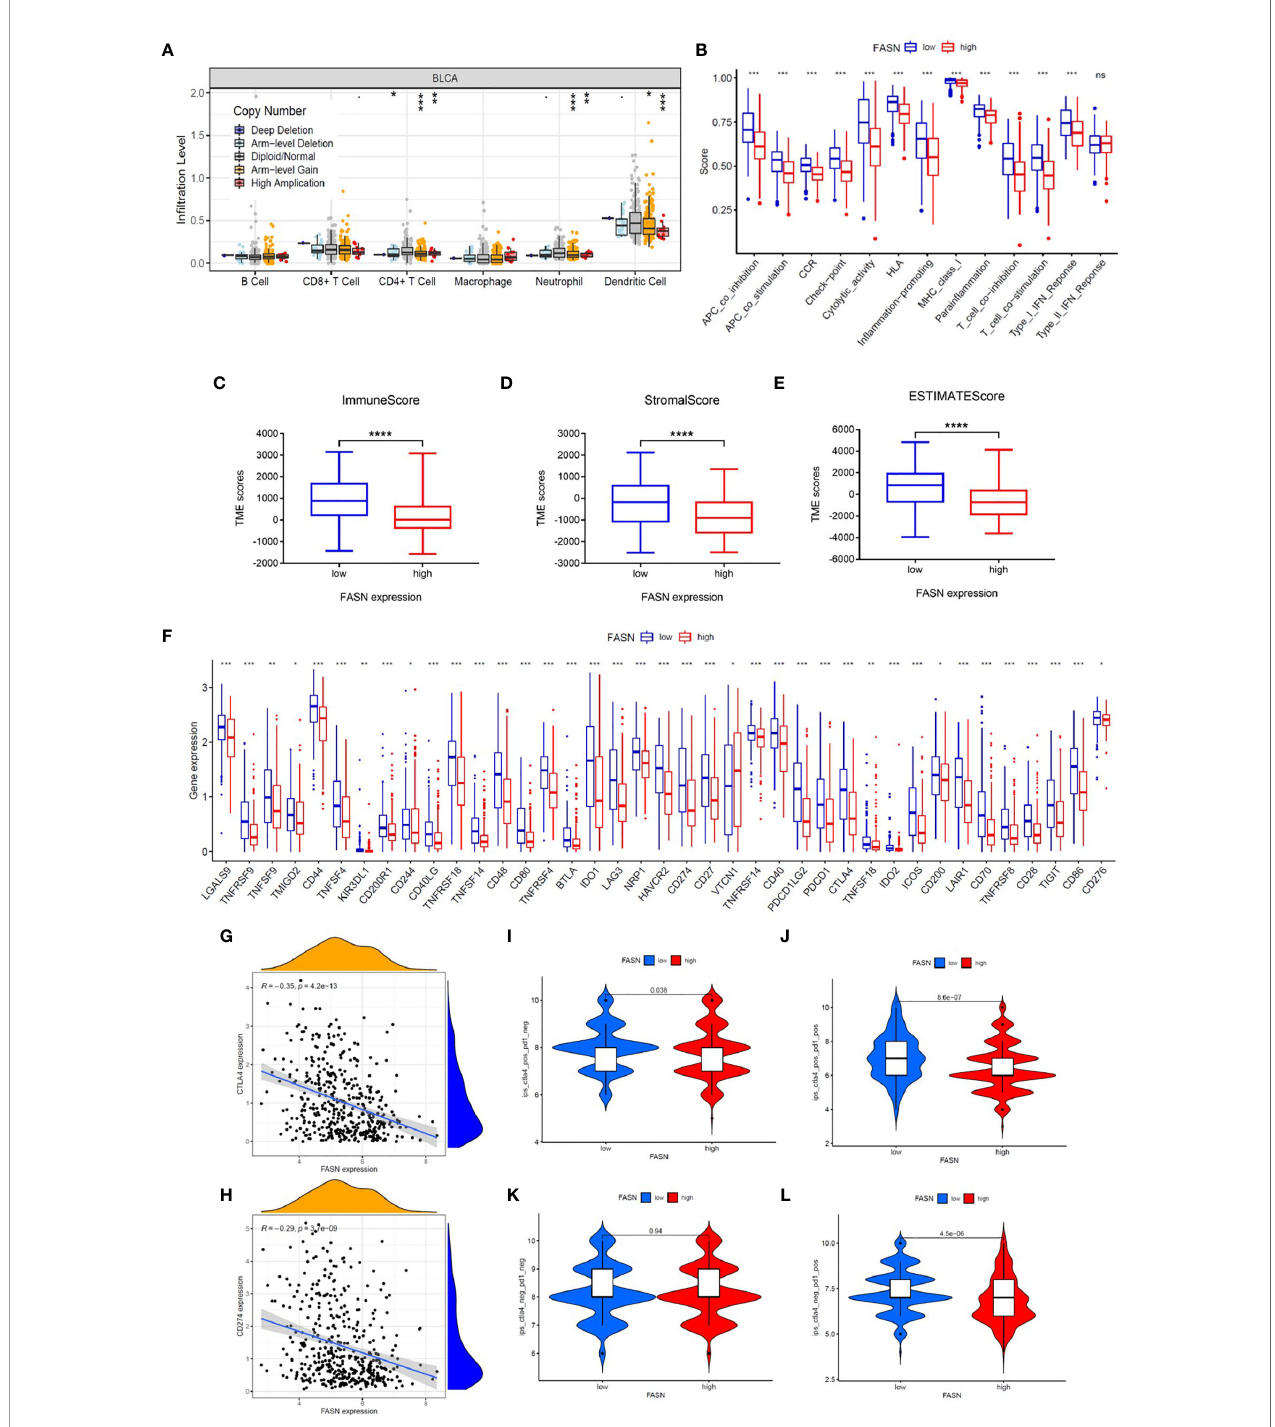
FIGURE 5 | Immune function of FASN. (A) Effect of FASN CNV status on immune cell in fi ltration. (B) ssGSEA scores of immune function between the low- and high-FASN groups. (C – E) Boxplot of TME score between low- and high-FASN groups. (F) Differential expression of 39 immune checkpoints between low- and high- FASN groups. (G, H) Scatter plot of correlation between CD274 (PD-L1), CTLA4 and FASN. (I – L) ICI treatment response of low and high-FASN groups. (ns p > 0.05, *p < 0.05, **p < 0.01, ***p < 0.001, ****p <